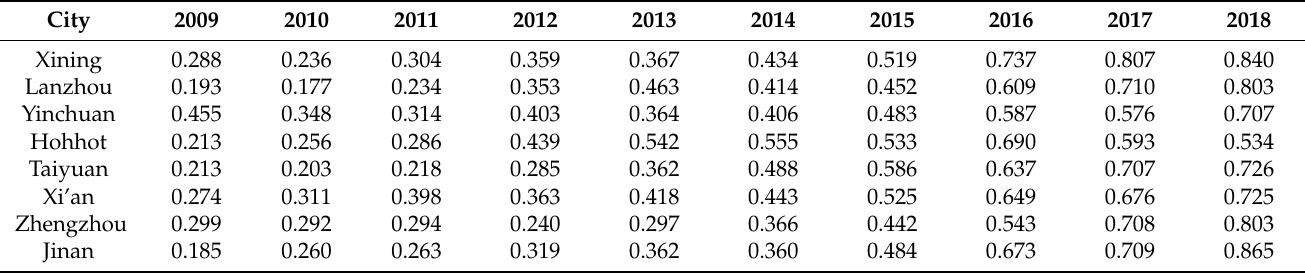
Table 4. Annual comprehensive score of SLU indexes for central cities in the Yellow River Basin,